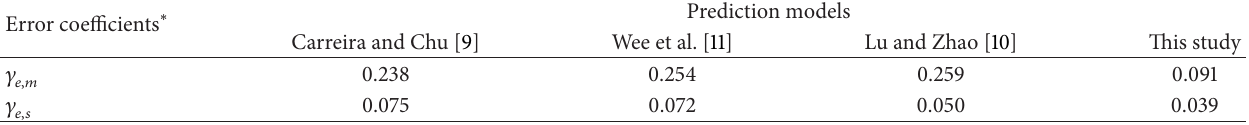
Table 3: Statistical values of NRMSEs calculated by comparing stress-strain curves of various models to experimental data.